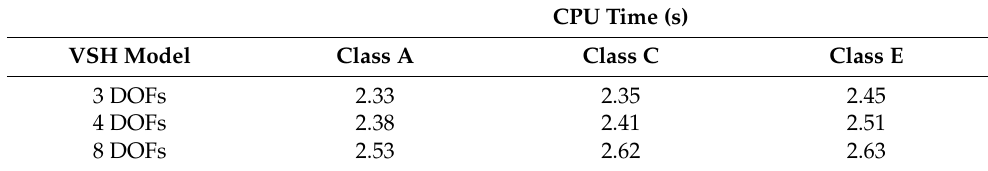
Table 11. The CPU time for all the VSH models in Class A, C and E road